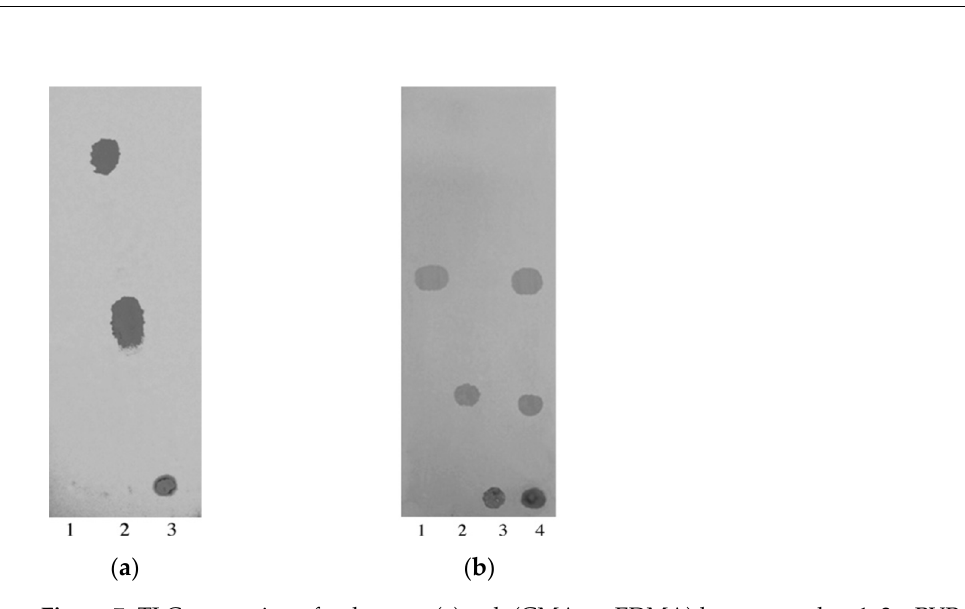
Figure 7. TLC separation of polymers: ( a ) poly(GMA-co-EDMA) layer; samples: 1–3—PVPs with M w = 14,400; 94,700 and 1,065,000, respectively; mobile phase: water–isopropanol = 90:10 ( v/v ); ( b ) poly(BMA-co-EDMA) layer; samples: 1–3—PSs with M w = 154,000; 500,000 and 960,000, respec- tively, 4—mixture of PSs; mobile phase: AcN–THF = 5:5 ( v/v ). Reprinted with permission of Elsevier from [52].